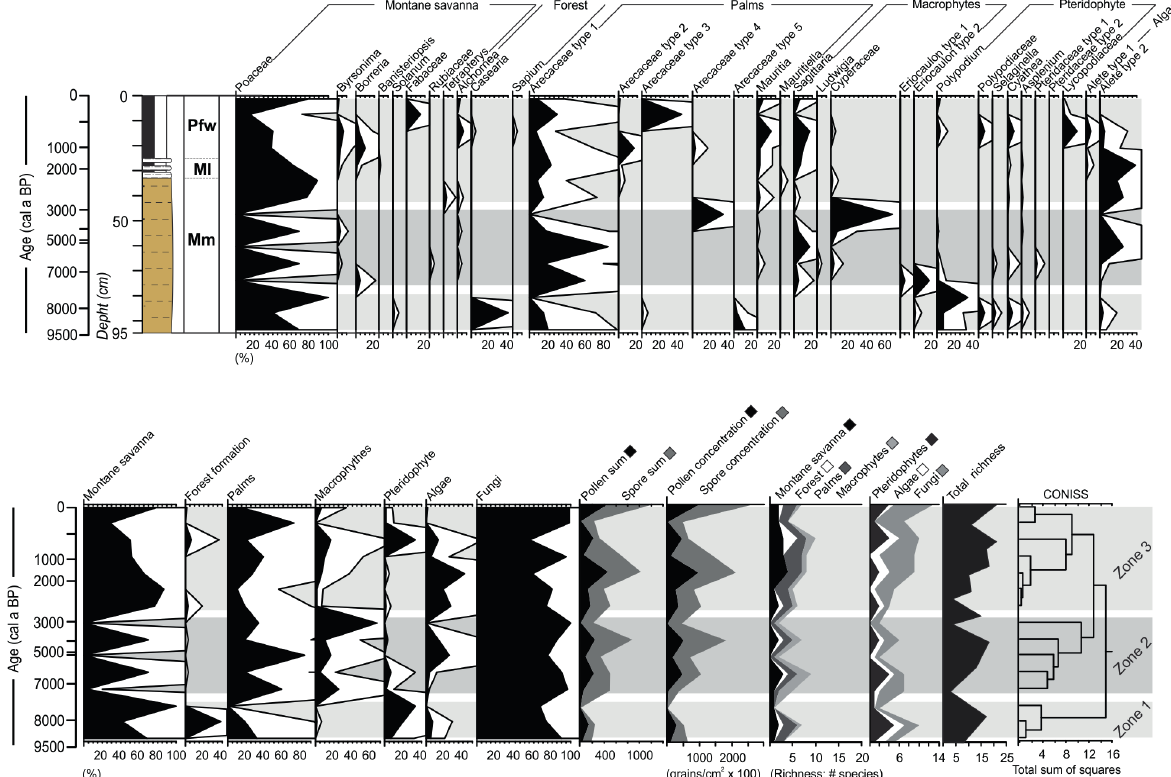
Figure 4 - Pollen diagram of the r4 core with percentages and concentration, as well as palynodiversity